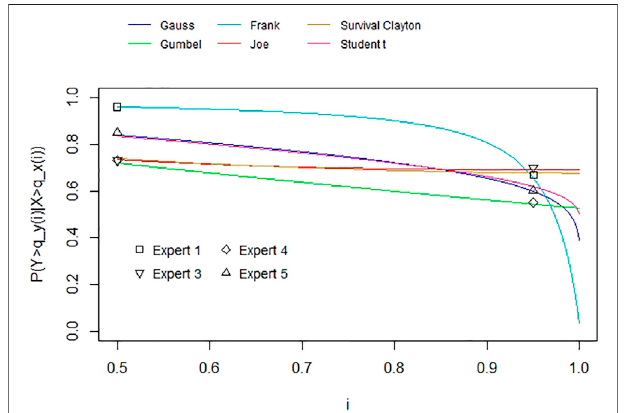
FIGURE 6 | Combined unconditional scenario of all experts for Escherichia coli resistance to third generation Cephalosporins in the United Kingdom in 2021.